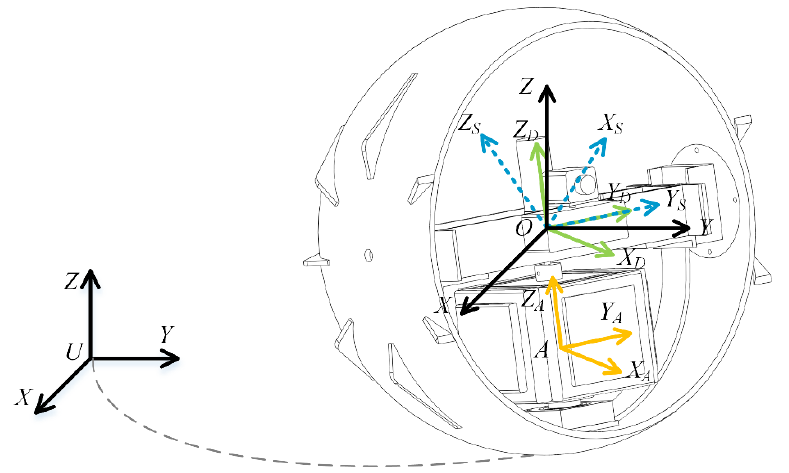
Figure 5. Coordinate frames of the robot.